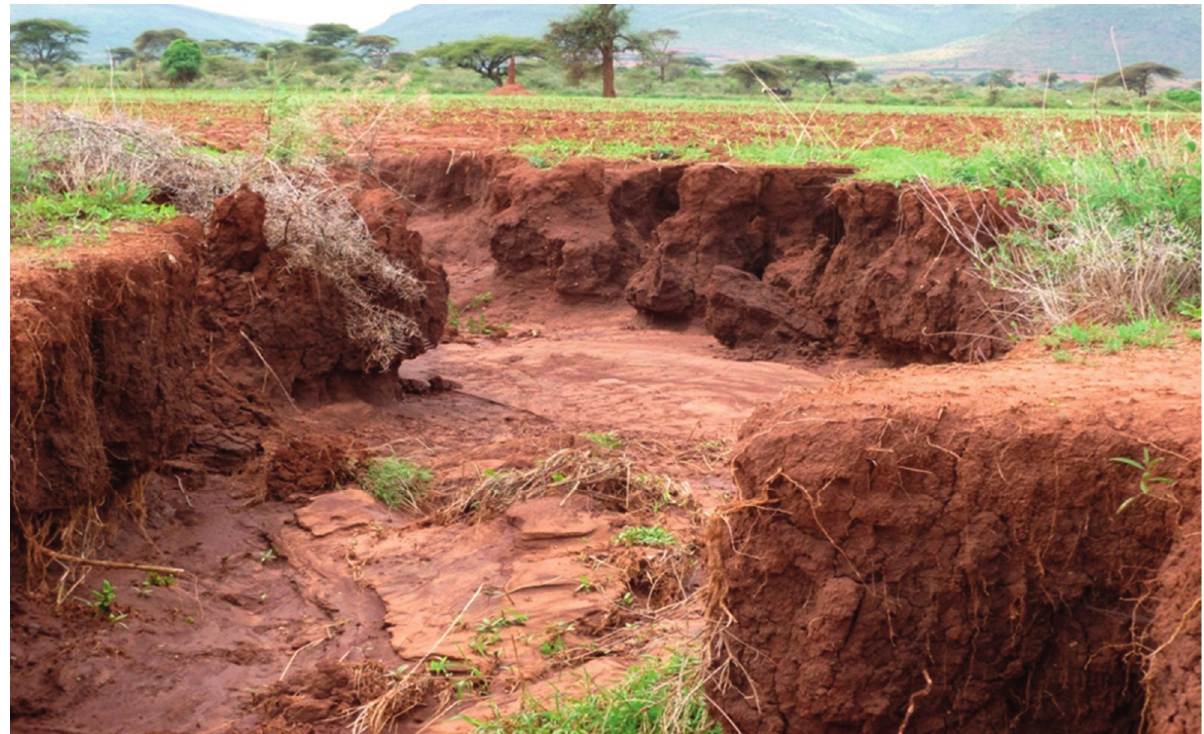
Figure 10. Development of gully erosions around cultivated land in the Did mega site (photo November